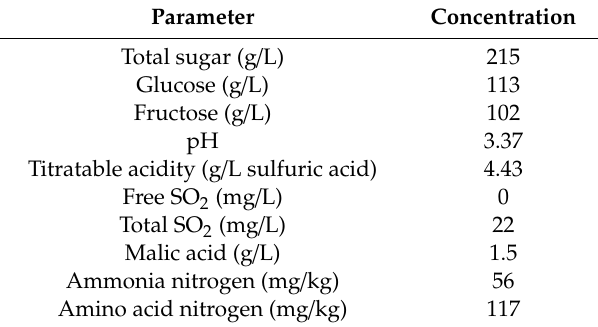
Table 1. Chemical characterization of Sangiovese grape juice used in the